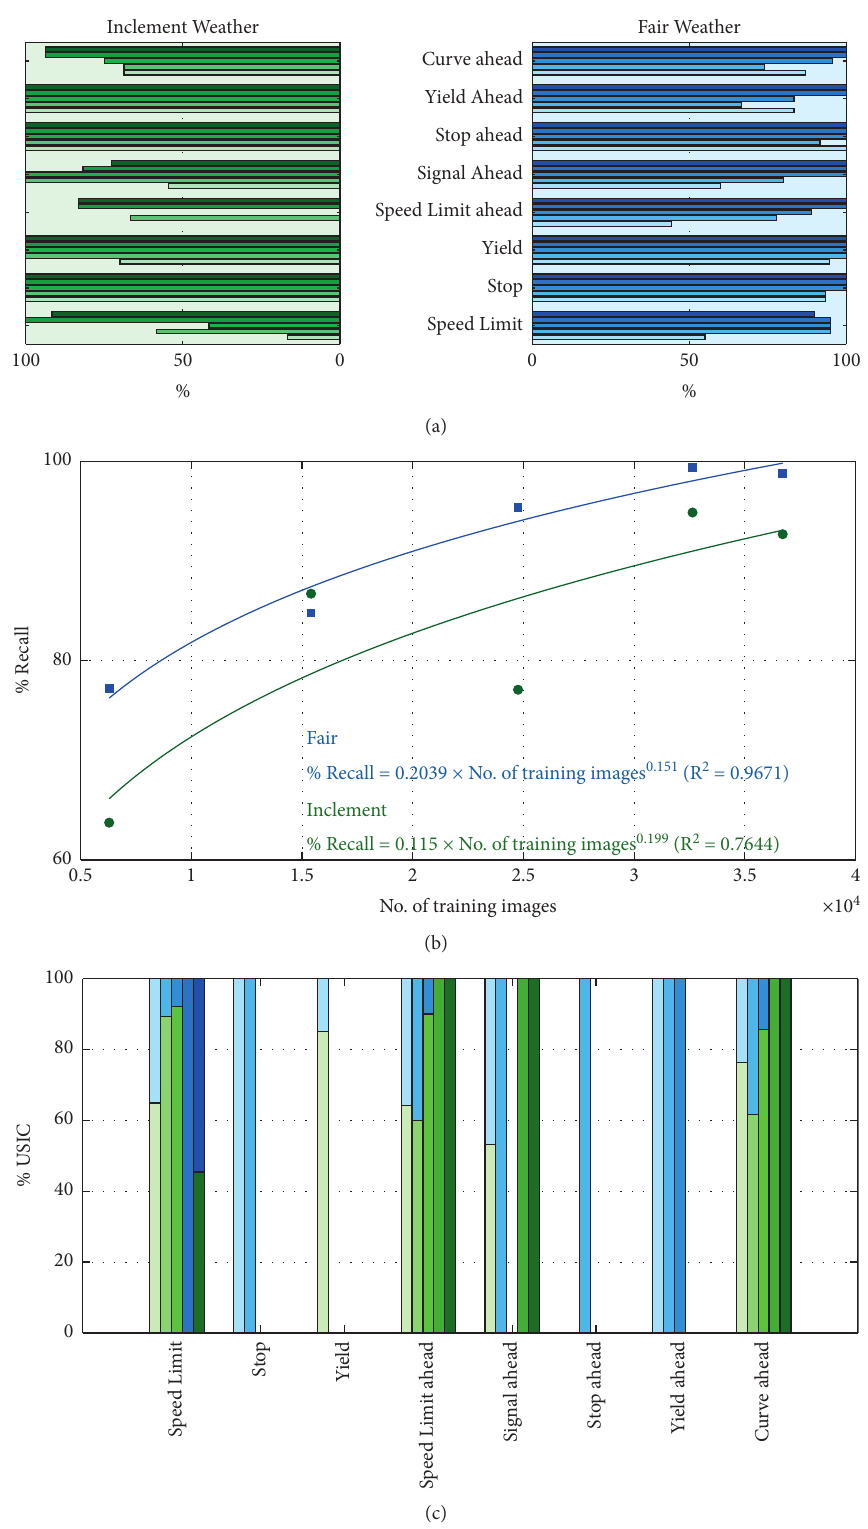
Figure 4: (a) Comparison of recall metric on studied weather conditions. (b) Progression of average recall values with an increasing number of training images. (c) Unidentified signs proportion of compared weather